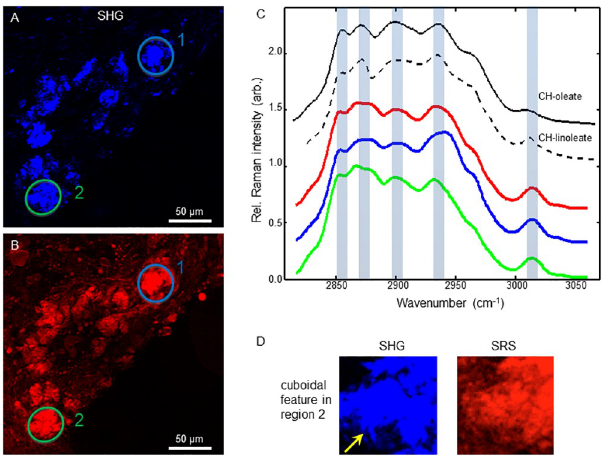
Fig 7. Hyperspectral scan of HIV + plaque aggregated cuboidal CCs detect a CE dominate signature. Left panels show the SHG (A, top) and SRS (B, bottom) with two regions of interest denoted (green and blue circles). Graphed right (C) are the SRS spectra of the individual objects (green and blue lines) and their average (red). The top black solid and dashed traces represent the SRS spectra of cholesteryl oleate and linoleate standards, respectively. Detail of green region 2 is shown in (D) for the SHG and SRS channels, and the cuboidal structure is indicated by the yellow arrow.